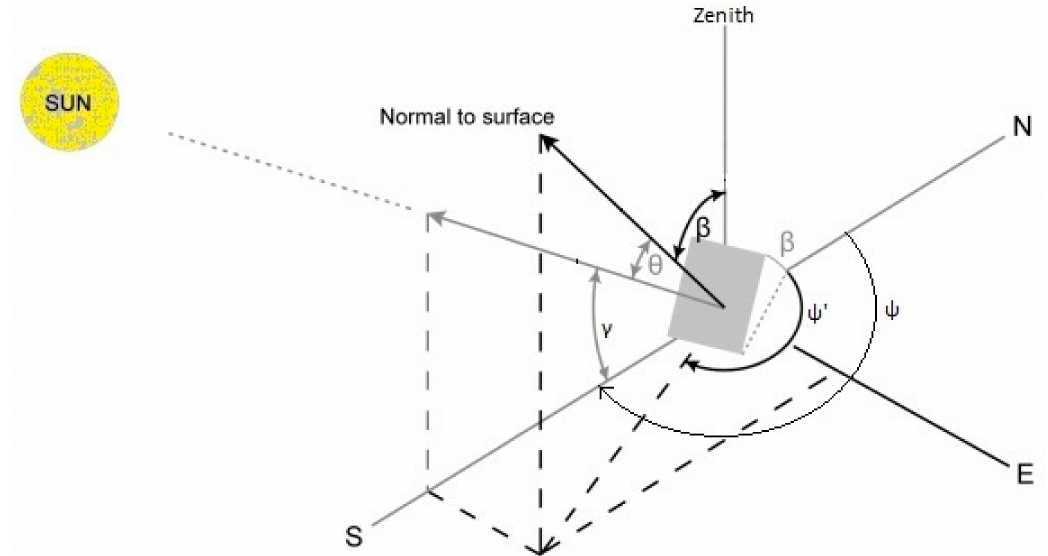
Figure 2. Definition of the incidence angle θ . The solar altitude γ , the tilt angle of the sloped surface β , and the azimuths of the solar position in the sky and of the orientation of the tilted plane ψ and ψ ’, respectively, are shown. In the case of the present work, ψ ’ = 180 ◦ (a south-facing surface). In the graph, the Sun is at its highest γ (local solar noon), which coincides with the southerly direction. The four main orientations in the local horizon of the sloped surface are also indicated (i.e., N(orth), E(ast), S(outh),